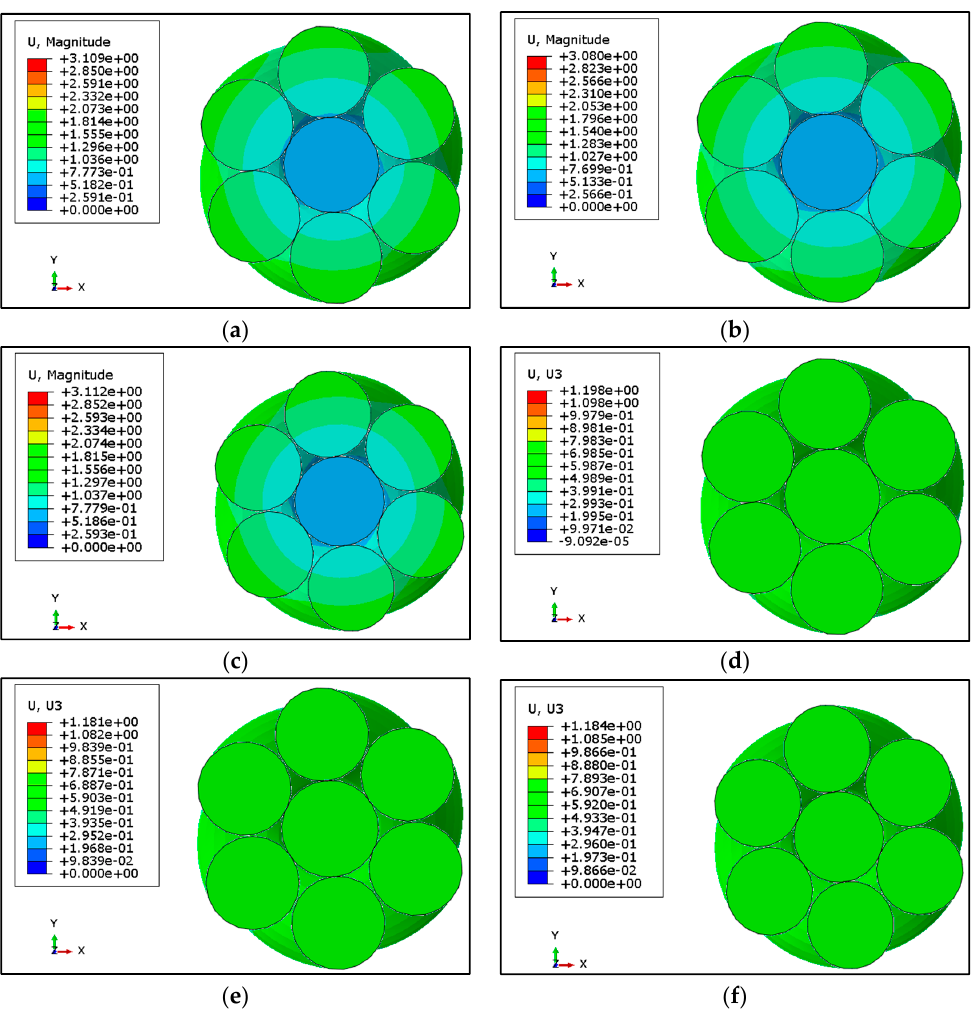
Figure 4. Total displacement (U, Magnitude) and Axial Displacement U3 in wire rope strand under axial loading for different surface conditions ( a ) Total Displacement without friction. ( b ) Total Displacement with coefficient of friction = 0.1. ( c ) Total Displacement with coefficient of friction = 0.2. ( d ) Axial Displacement (U3) without friction. ( e ) Axial Displacement U3 with coefficient of friction = 0.1. ( f ) Axial Displacement with coefficient of friction = 0.2.